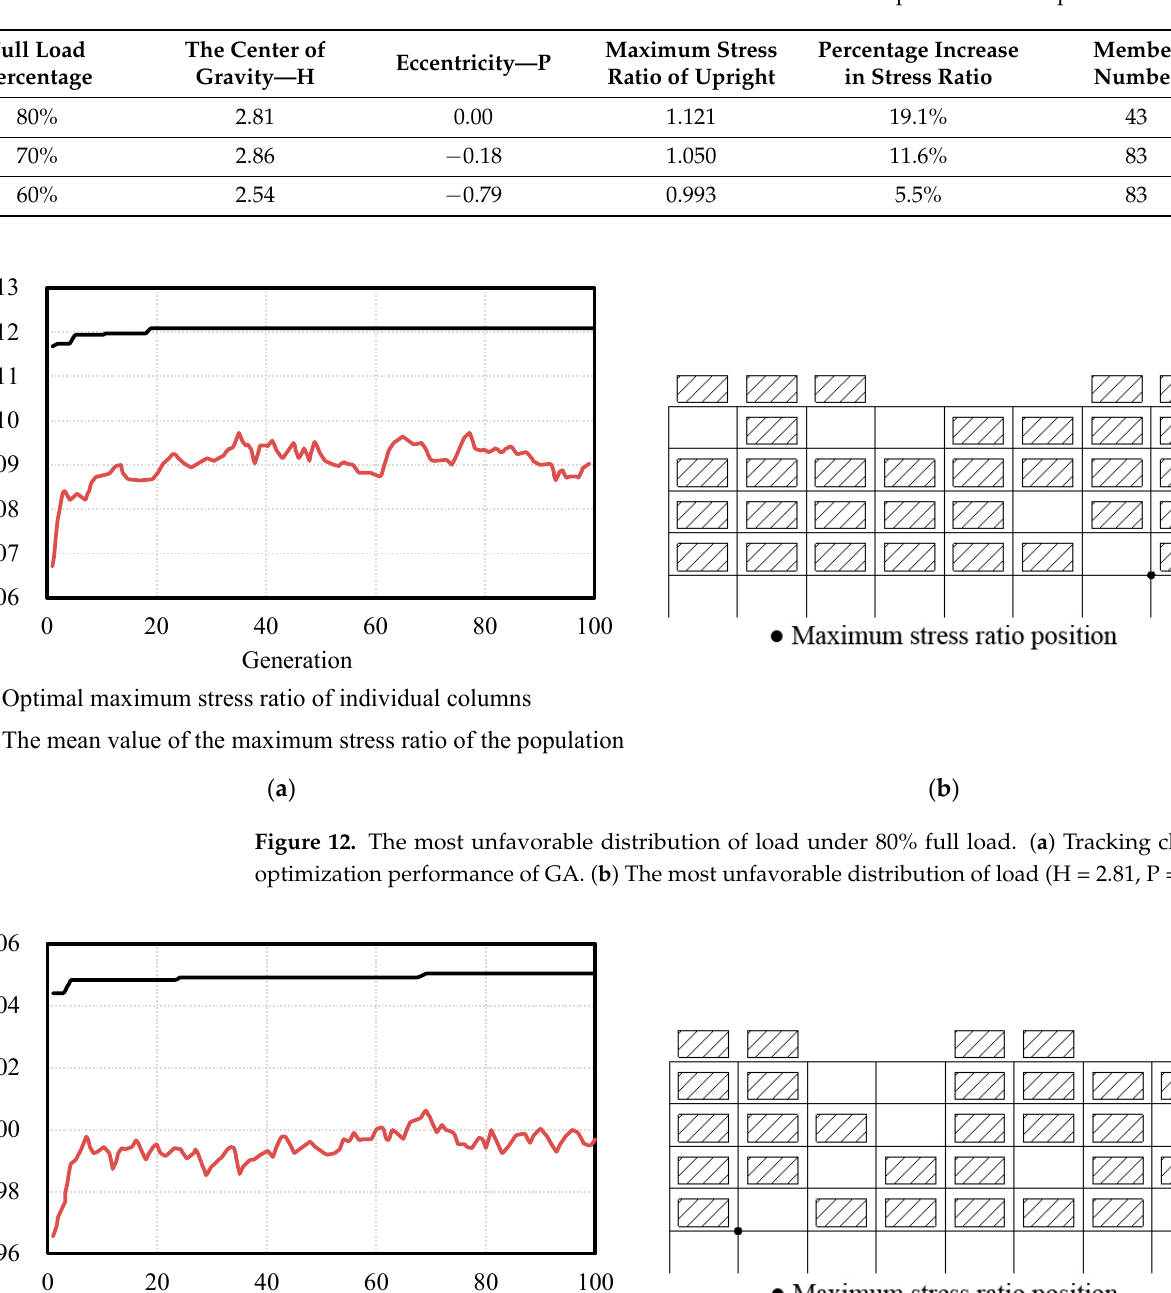
Table 5. Parameters related to the most unfavorable distribution patterns of the optimized loads.